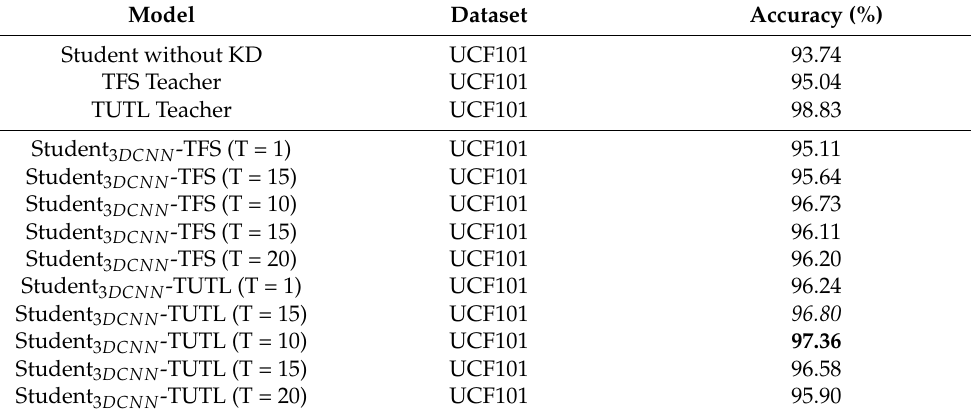
Table 6. Quantitative comparative analysis of the results obtained by our proposed framework with and without knowledge distillation (KD) with different settings over UCF101 dataset.